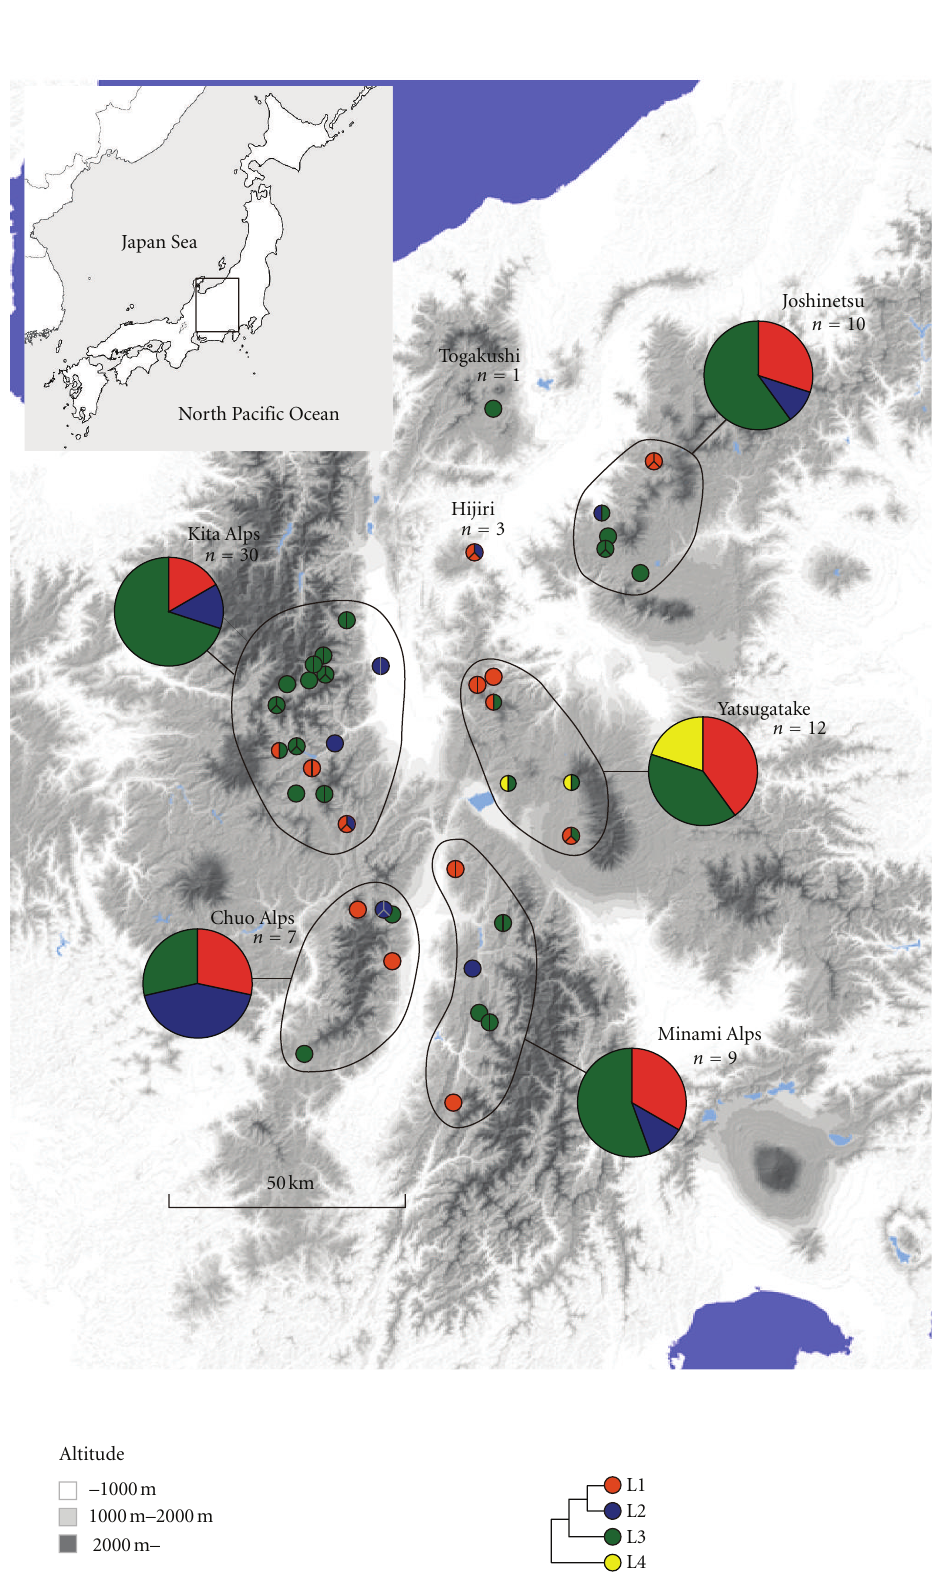
Figure 3: Geographical distribution of ant clades in the Japanese Alps. Small circles show the locations of collection sites, and divided symbols show the number of ant colonies at the same collection site. The pie charts show the proportional abundance of the clades within each mountain range with the sample size